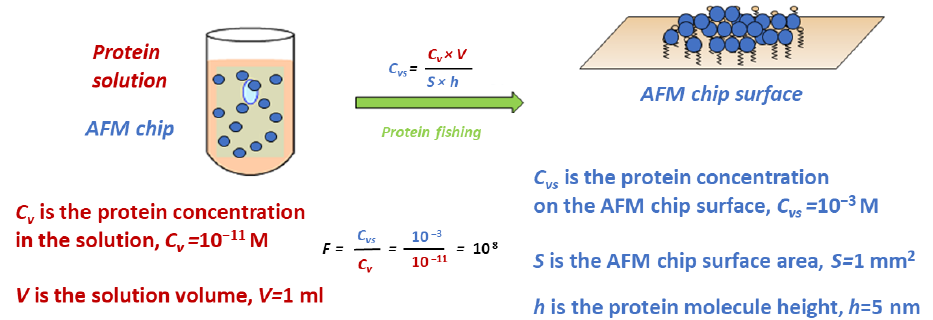
Figure 1. Schematic representation of the protein fishing